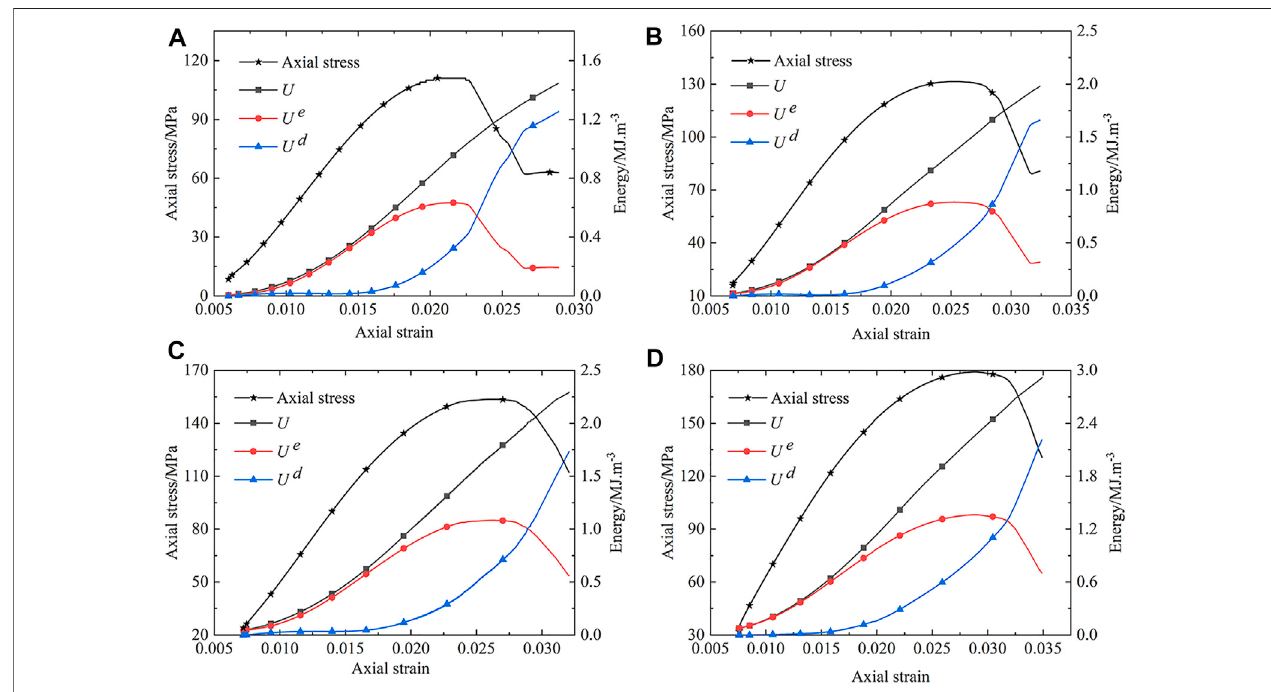
FIGURE 7 | Energy evolution curve of the specimen under different con fi ning pressures. (A) Con fi ning pressure = 8 MPa; (B) con fi ning pressure = 16 MPa; (C) con fi ning pressure = 24 MPa; (D) con fi ning pressure = 32 MPa.